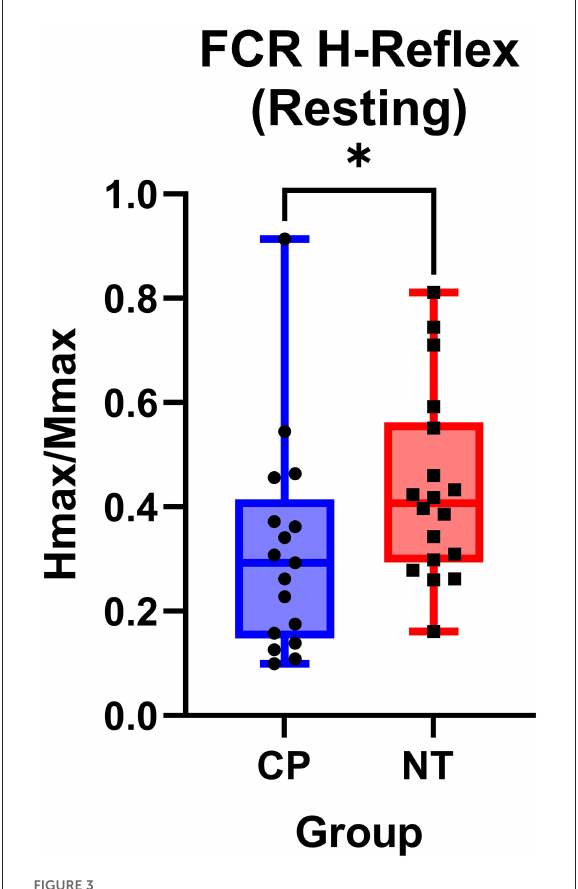
FIGURE3 The flexor carpi radialis H:M ratio is higher in neurotypical adults compared to adults with cerebral palsy. Box-and-whisker plots of the resting flexor carpi radialis H:M ratios for neurotypical (NT) adults and adults with cerebral palsy (CP). Data are plotted with values standardized to a % of the Mmax and whiskers indicating the minimum and maximum values. As shown, the H:M ratios at rest were significantly smaller in the adults with CP, when compared with the NT controls. * Indicates P < 0.05.